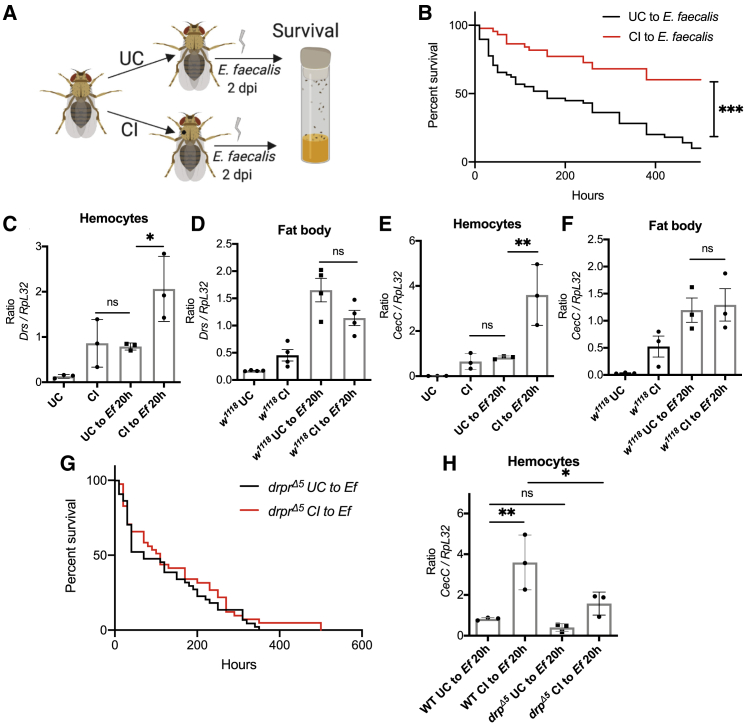
Injury Protects Flies from a Subsequent Systemic Infection(A) Experimental setup for determining immune training after an injury to a pathogen systemic infection. Flies were either injured or left undisturbed prior to infection with E. faecalis.(B) Survival of flies following infection with E. faecalis as indicated in (A) (w1118; UC, n = 58; CI, n = 44).(C–F) qRT-PCR of the AMPs CecC and drosomycin (drs) expression in hemocytes and fat body of naive versus injured flies w1118 flies that were subsequently infected with E. faecalis for 20 h.(G) Survival of drprΔ5 mutant flies with E. faecalis as indicated in (A).(H) qRT-PCR in wild-type and drprΔ5 mutant flies in hemocytes of naive versus injured flies that were subsequently infected with E. faecalis for 20 h. The loss of response to the ROS signal upon wounding in leads to an attenuated hemocyte AMP activation to infection with E. faecalis.UC, unchallenged; CI: clean injury; Ef, E. faecalis. For (C)–(F) and (H), data represent ±SD. ∗p < 0.05; ns, non-significant.